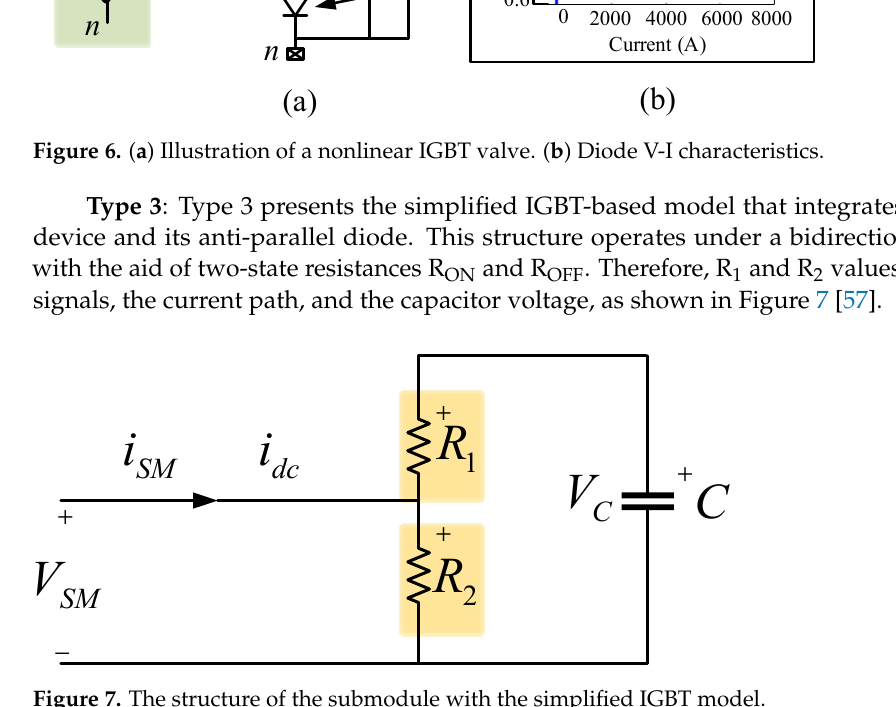
Figure 7. The structure of the submodule with the simplified IGBT model. Type 4 : Type 4 depicts the detailed equivalent-circuit-based model that uses the simple circuit with the required modification. This type of configuration is built using a Thevenin equivalent for every arm of the converter without considering the inner central nodes